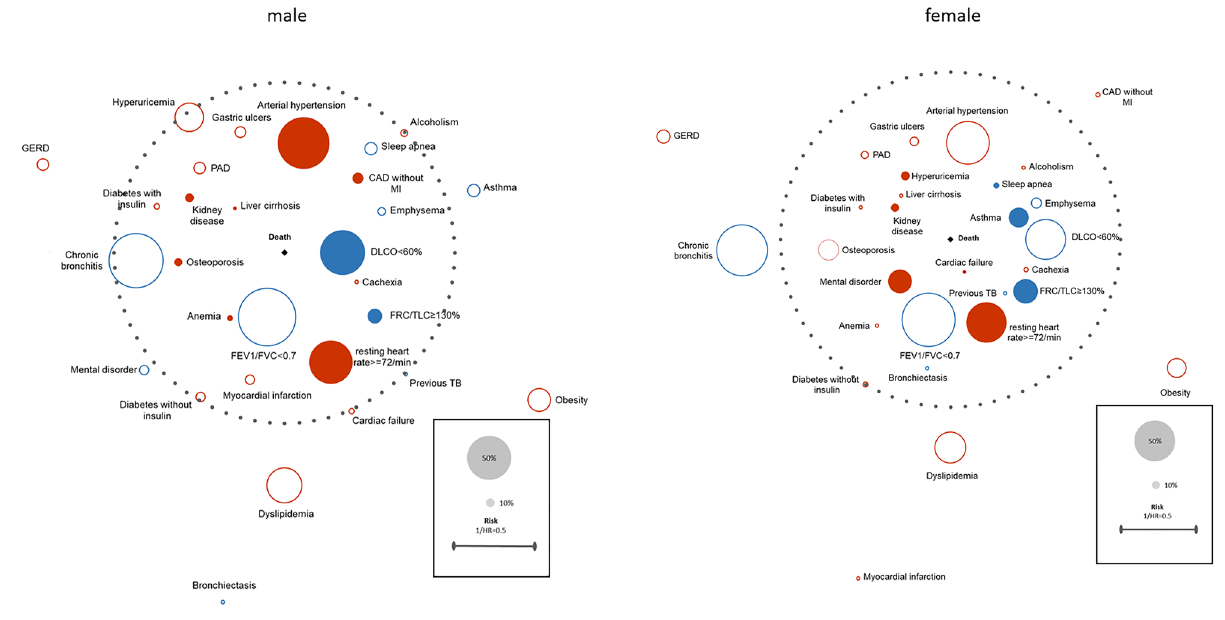
Figure 1. The left panel of this figure refers to men, the right panel to women. Each panel shows the hazard ratio as well as the prevalence of the comorbidities analyzed. Statistically significant associations ( p < 0.05) are indicated by filled circles, those being not significant by open circles. Comorbidities that are part of the comorbidome are marked in red, those of the pulmorbidome in blue. The area of each circle represents the prevalence in the respective population. The dotted circle indicates a hazard ratio of 1. The distance of comorbidities from the circle and its center indicates the magnitude of the hazard ratio (see Supplemental Tables S1–S4), with hazard ratios greater than 1 plotted inwards and hazard ratios less than 1 outwards. This inverse type of plot was chosen to keep the figure